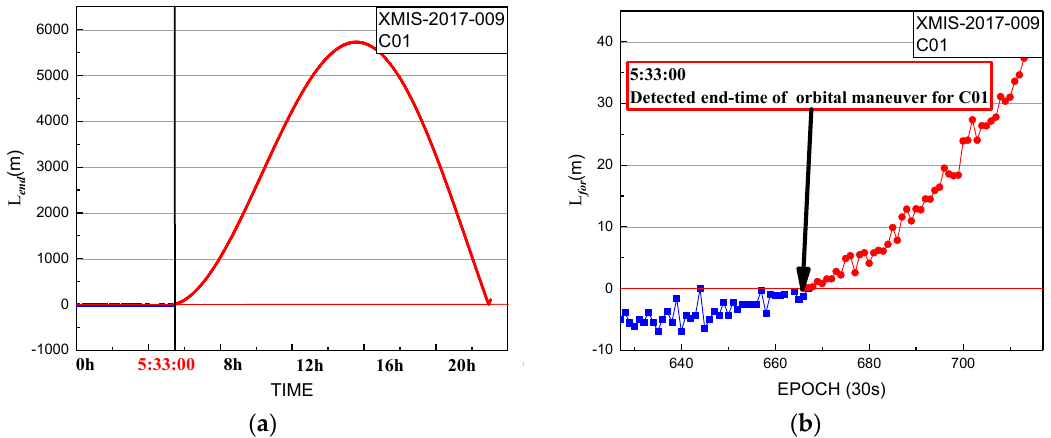
Figure 5. End time factor of XMIS station for C01 on 9 January 2017: (b) detailed information from graph in (a).